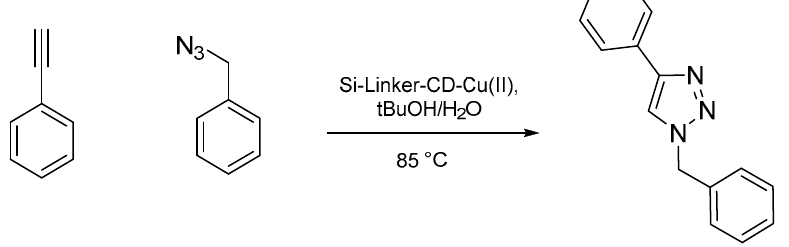
Figure 3. Infrared ( A ) and diffuse reflectance UV-Vis ( B ) spectra of (a) Si-Gly-CD-Cu; (b) Si-MonoAm- CD-Cu; (c) Si-DiAm-CD-Cu; (d) Si-TriAm-CD-Cu. Before infrared measurements samples were